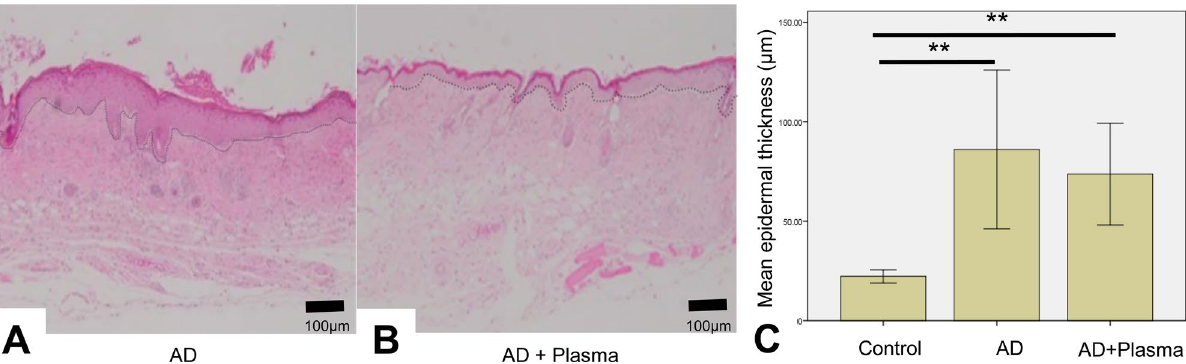
Figure 6. The effect of plasma treatment on the epidermal thickness of atopic dermatitis-induced mice. On Day 17, the ear skin of the mice were sampled and tissue sections with hematoxylin and eosin (H&E) stains